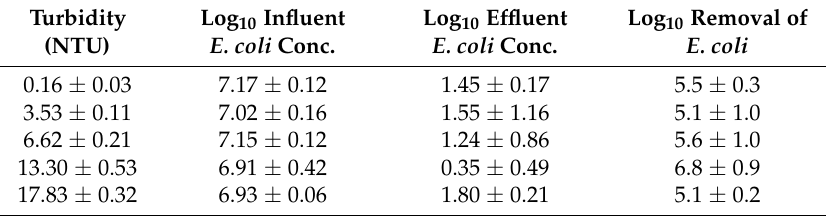
Table 6. Impact of turbidity on disinfection